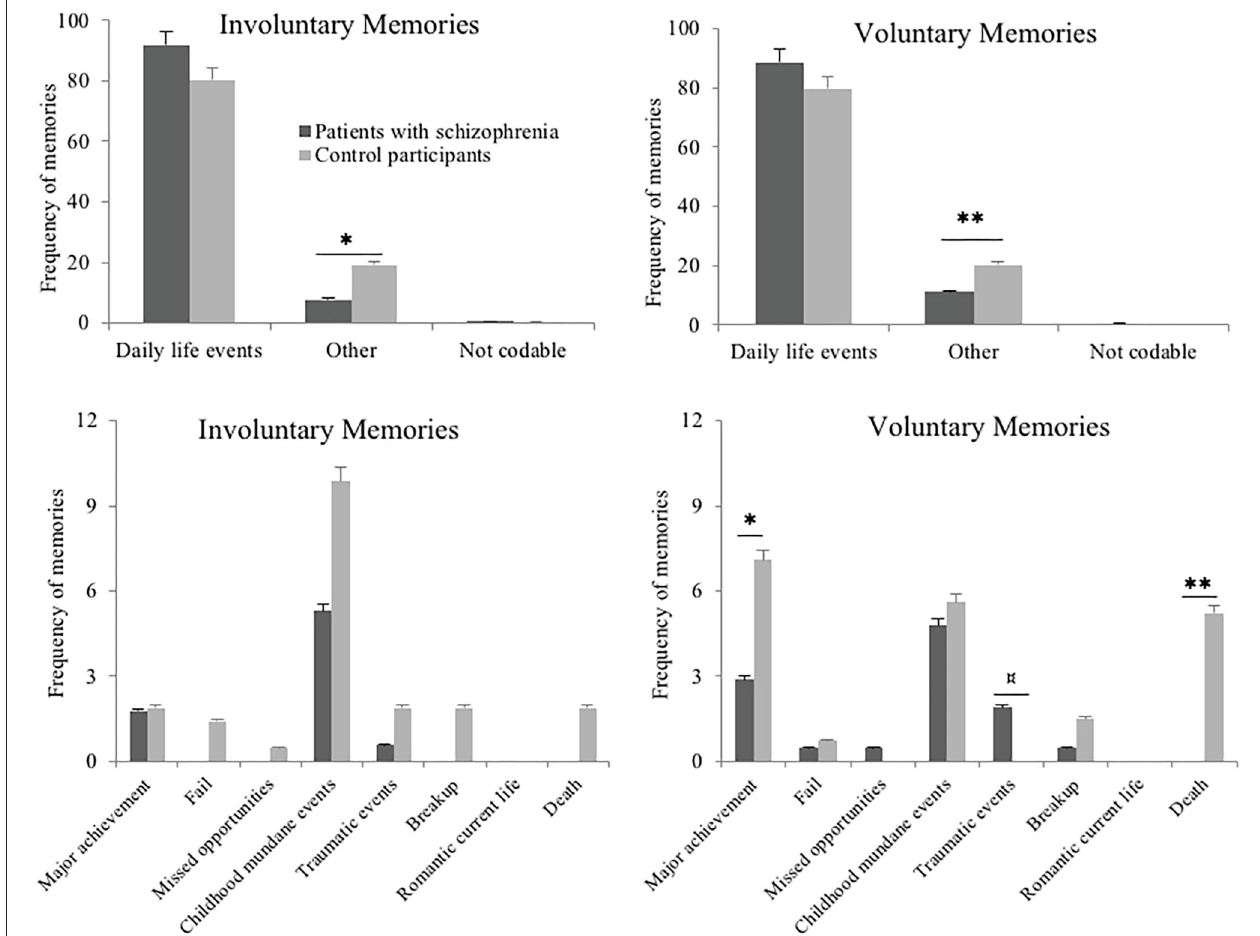
FIGURE 4 | The upper plots show the frequencies of involuntary and voluntary autobiographical memories related to mundane daily life events or other categories of event, in patients with schizophrenia and in control participants, in Study 2. The lower plots show the distribution of these other categories of event, across groups and separately for involuntary and voluntary memories, in Study 2. Error bars represent standard errors. ¤ p < 0.10; * p < 0.05; ** p ≤ 0.01.